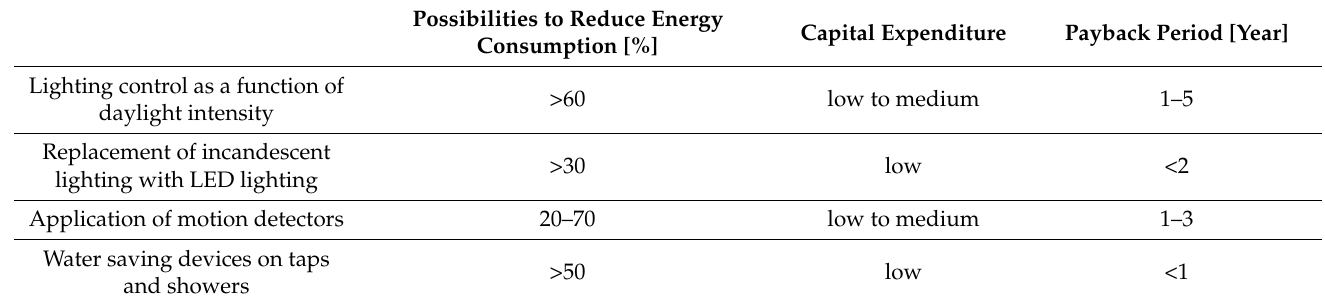
Table 7. Savings on hotel energy